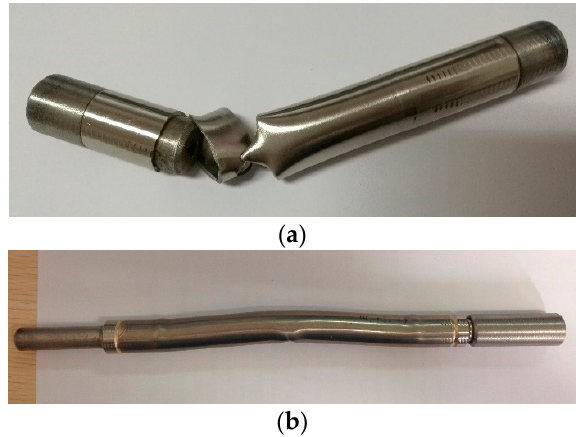
Figure 5. Typical failures of as-received tube: ( a ) rupture near the clip position; ( b ) buckling.